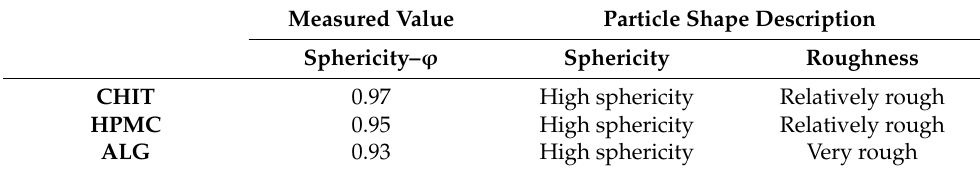
Table 1. Measurement of pellet sphericity.